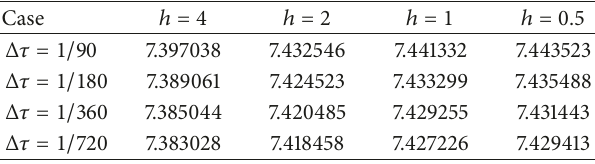
Table 1: Convergence test for European call option values.